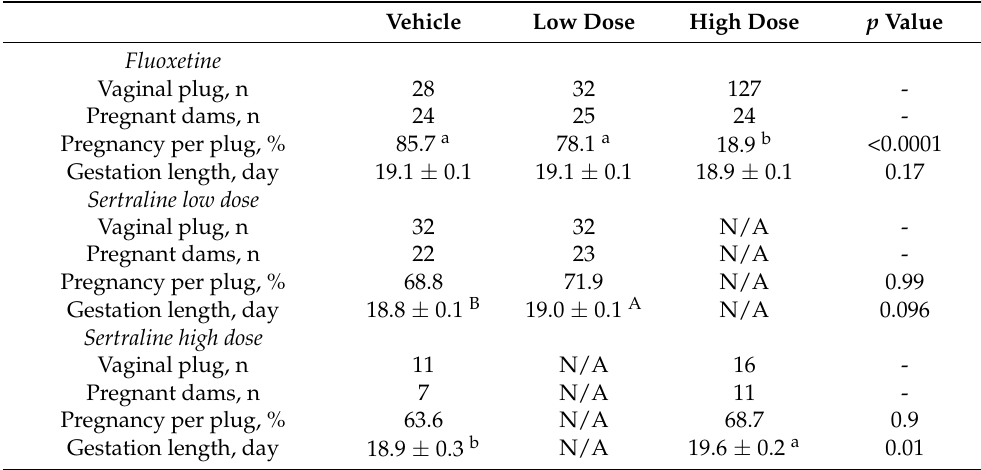
Table 2. Effect of low and high doses of fluoxetine and sertraline on pregnancy